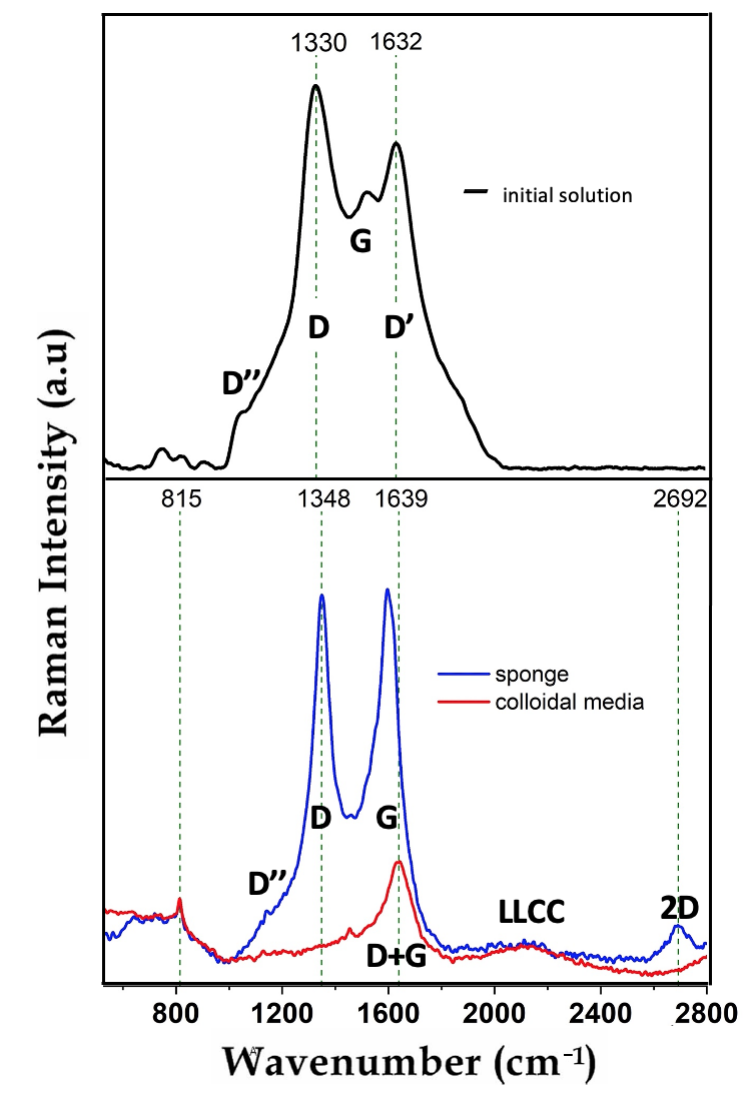
Figure 2. Raman spectra: the top panel is relevant to the initial colloidal system, the bottom panel shows the Raman spectrum of the system after the field-induced assembly. The spectra were taken separately for a sedimented sponge (marked by the blue curve) and the depleted colloidal media (marked by red